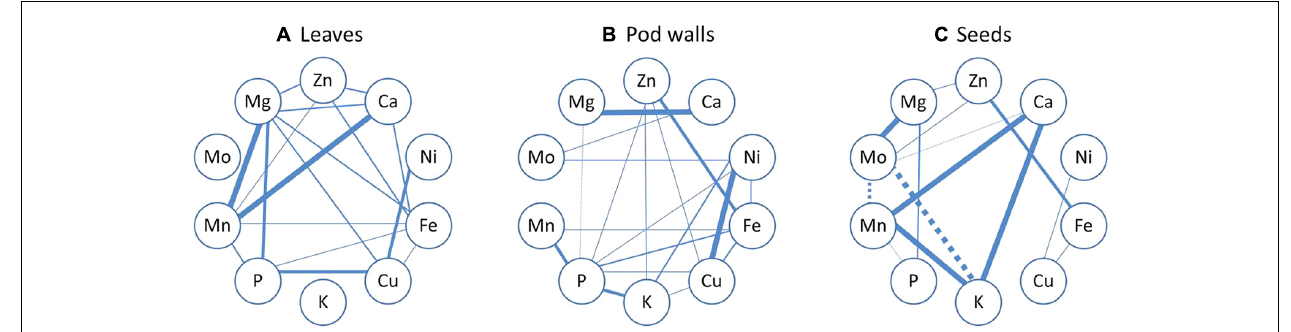
correlation and dashed lines represent a significant negative correlation. Thinner lines indicate significance at the P < 0.05, semi-thin indicate significance at the P < 0.01, semi-thick indicate significance at the P < 0.001 level and the thicker lines indicate significance at the P < 0.0001 level.